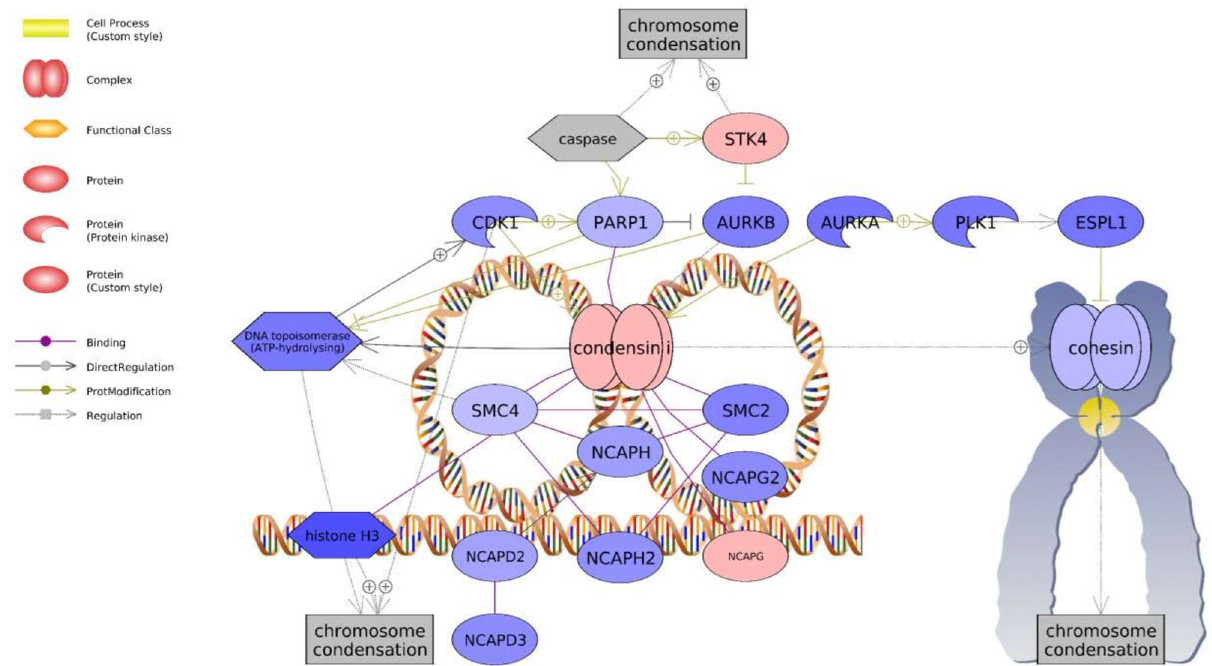
Figure 4. Chromosome condensation-associated network identified in the hypothalamus following PNX treatment. Red indicates an upregulated gene in the network (darker shade indicates greater log2 fold change compared to control), while blue indicates a downregulated gene. Shapes and arrows are identified in the legend to the left. This is a proposed mechanism based only on transcriptomic